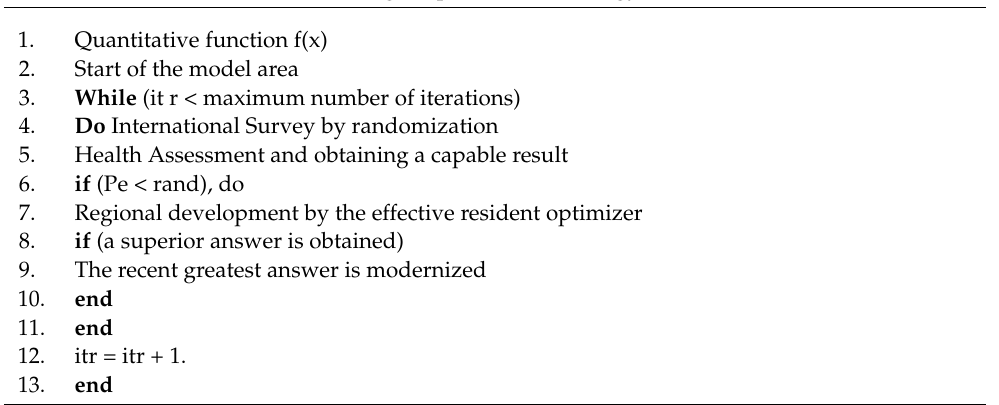
Algorithm 2 : Pseudo-code for the Eagle Optimization